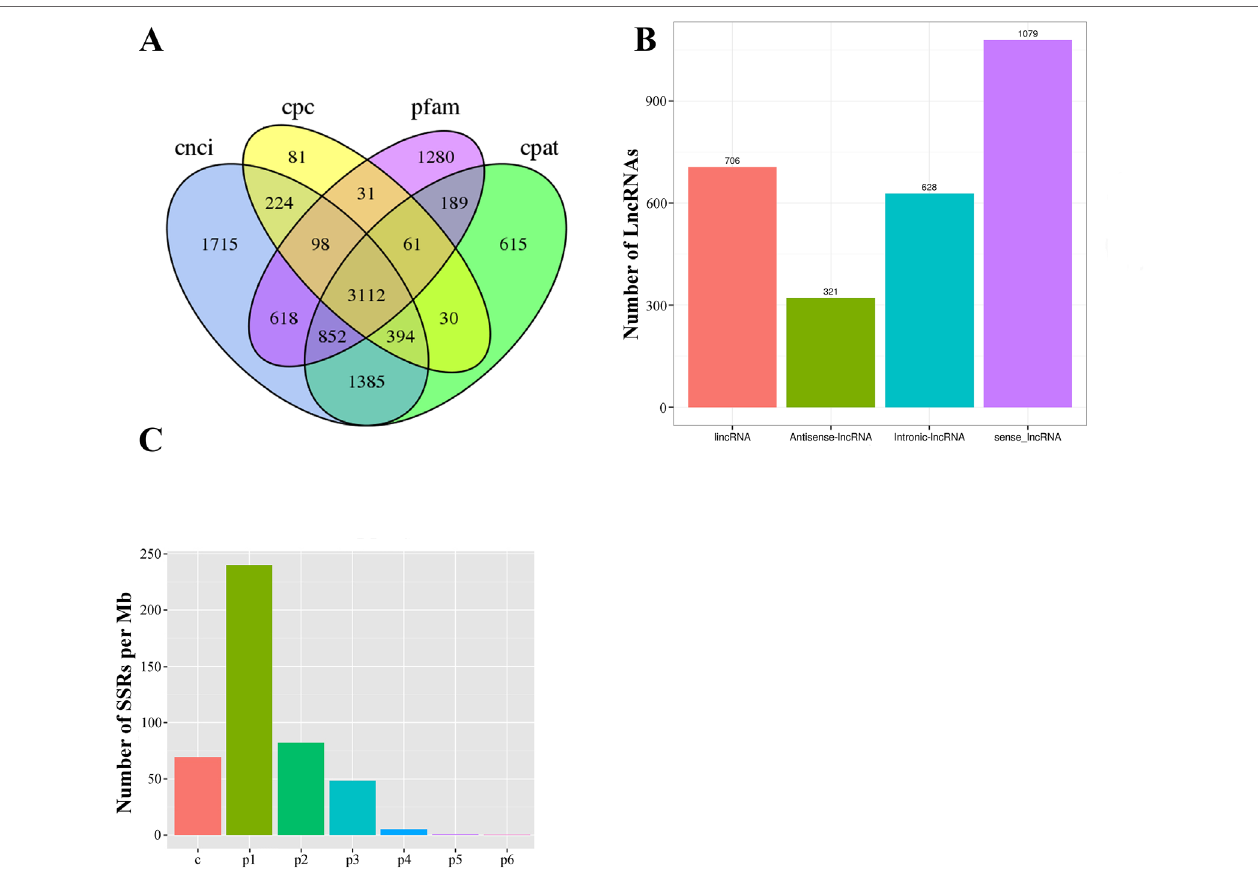
FIgURe 6 | Statistics of long non-coding RNA and SSR in L. maculatus . (a) Venn diagram showing the number of lncRNAs annotated by four computational approaches including CPC, CNCI, CPAT, and Pfam. (B) The number of four types of lncRNA based on biogenesis positions relative to protein-coding genes. (C) Density of SSR motifs. c, compound SSR; p1: Mono-nucleotide SSR; p2, Di-nucleotide SSR; p3, Tri-nucleotide SSR; p4, Tetra-nucleotide SSR; p5, Penta- nucleotide SSR; p6, Hexa-nucleotide